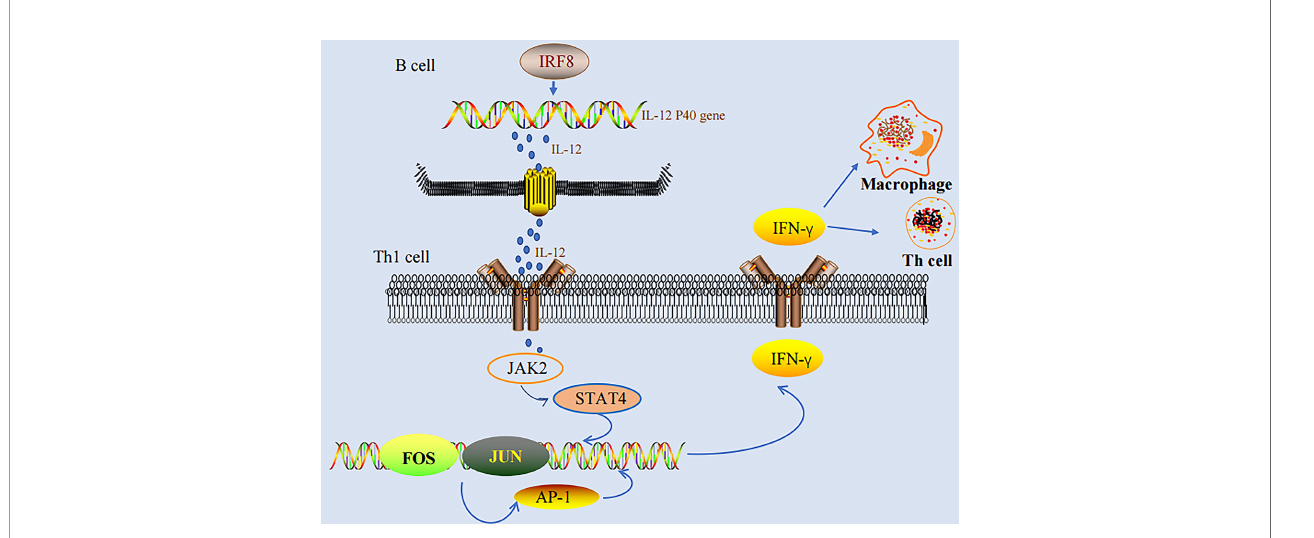
FIGURE 1 | IRF-8-IL-12-IFN- g pathway and AP-1-IFN- g